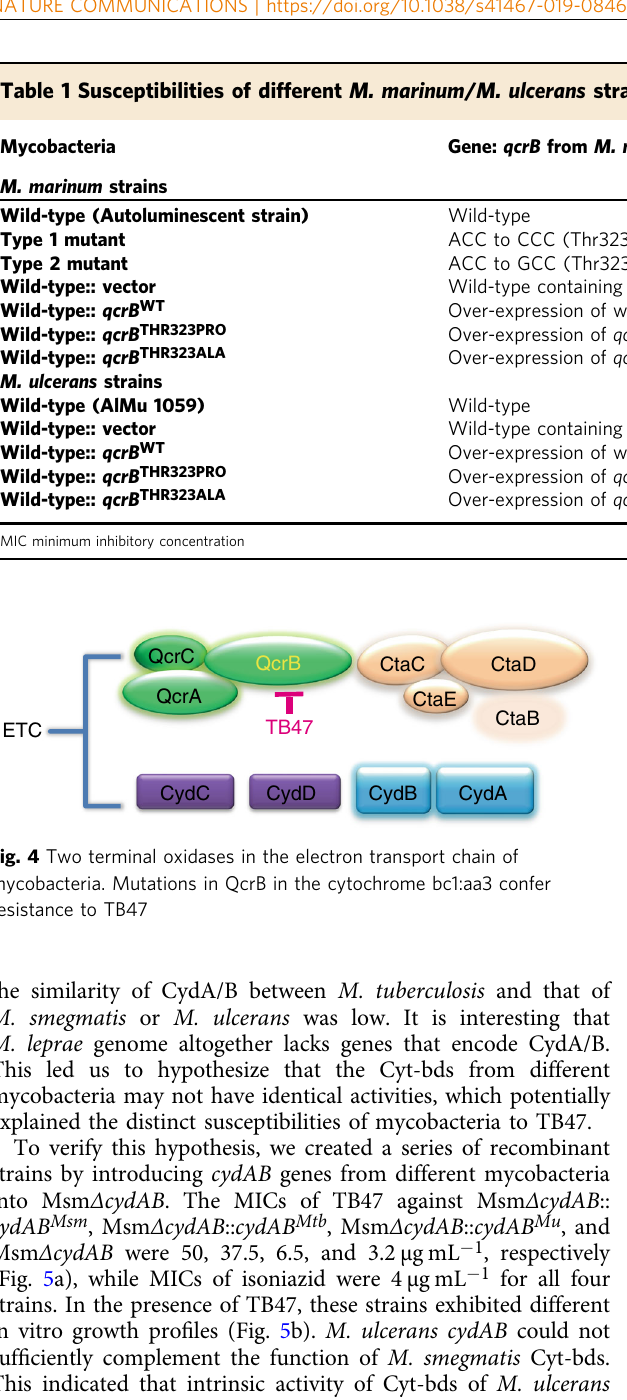
(Fig. 5a), while MICs of isoniazid were 4 μ g mL − 1 for all four strains. In the presence of TB47, these strains exhibited different in vitro growth pro fi les (Fig. 5b). M. ulcerans cydAB could not suf fi ciently complement the function of M. smegmatis Cyt-bds. This indicated that intrinsic activity of Cyt-bds of M. ulcerans could be too weak, which may explain well why TB47 had